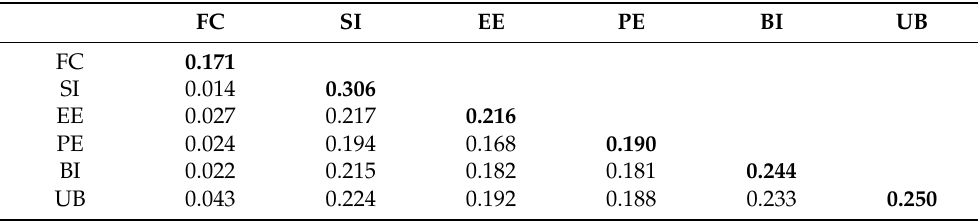
Table 5. Interconstruct correlations and discriminant validity (Fornell–Larcker Criterion [95]). Note: The items on the diagonal on bold represent the square roots of the AVE.